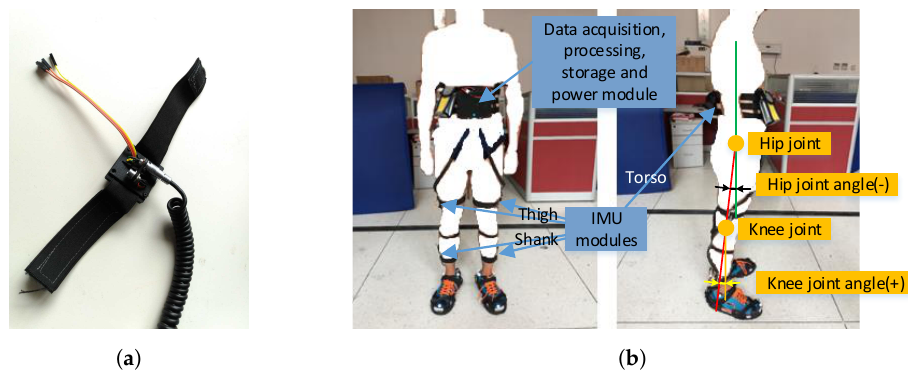
Figure 1. The inertial measurement unit (IMU)-based lower limb motion capture system. ( a ) One IMU module. ( b ) The system worn on a testing subject and the illustration of joint angles in the human sagittal plane collected in this research.